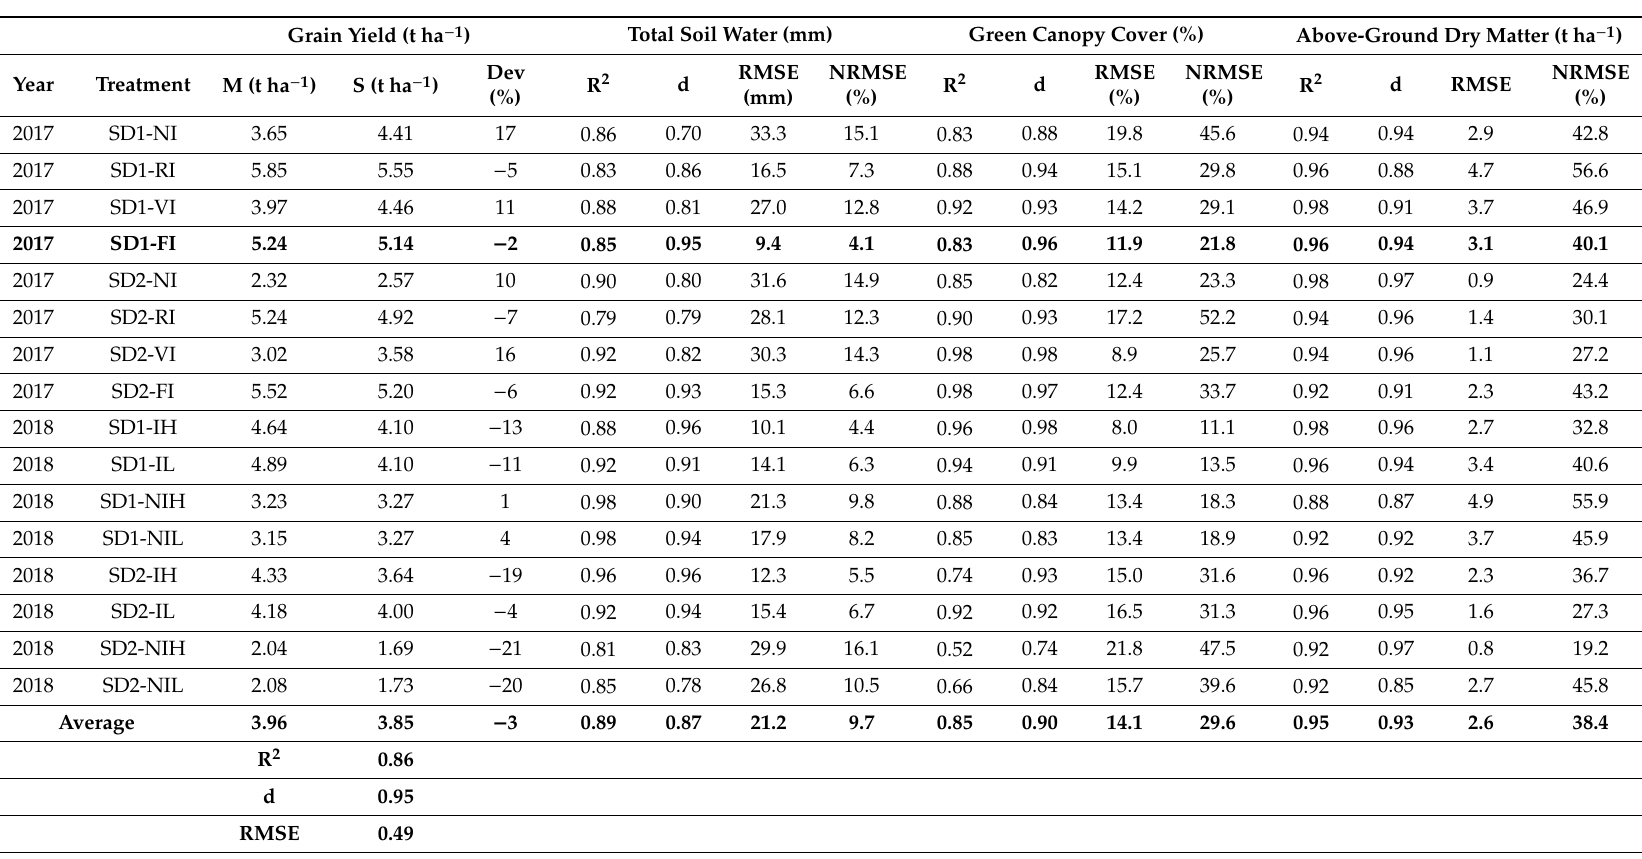
Table 3. Statistical evaluation parameters and values for grain yield, total soil water, green canopy cover, and above-ground dry matter for calibration and validation treatments of faba bean in 2017 and